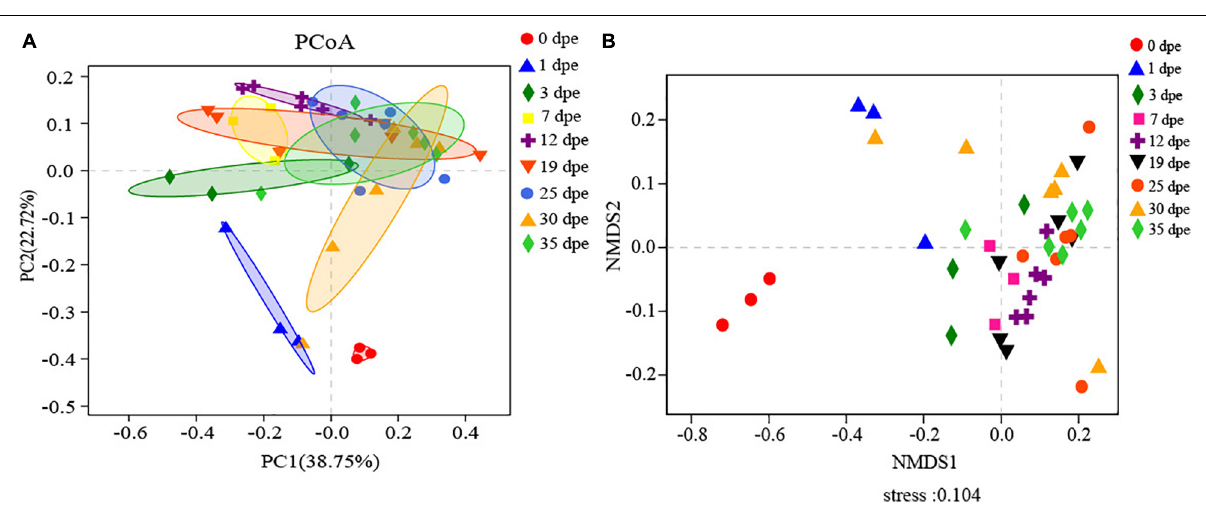
FIGURE 3 | (A,B) The horizontal and vertical coordinates represent the two selected principal coordinate components, and the percentage represents the contribution value of the principal coordinate component to the sample composition difference. The scales of the horizontal and vertical axes are relative distances and have no practical significance. Points of different colors or shapes represent samples of different groups. The closer the two sample points are, the more similar the species composition of the two samples will